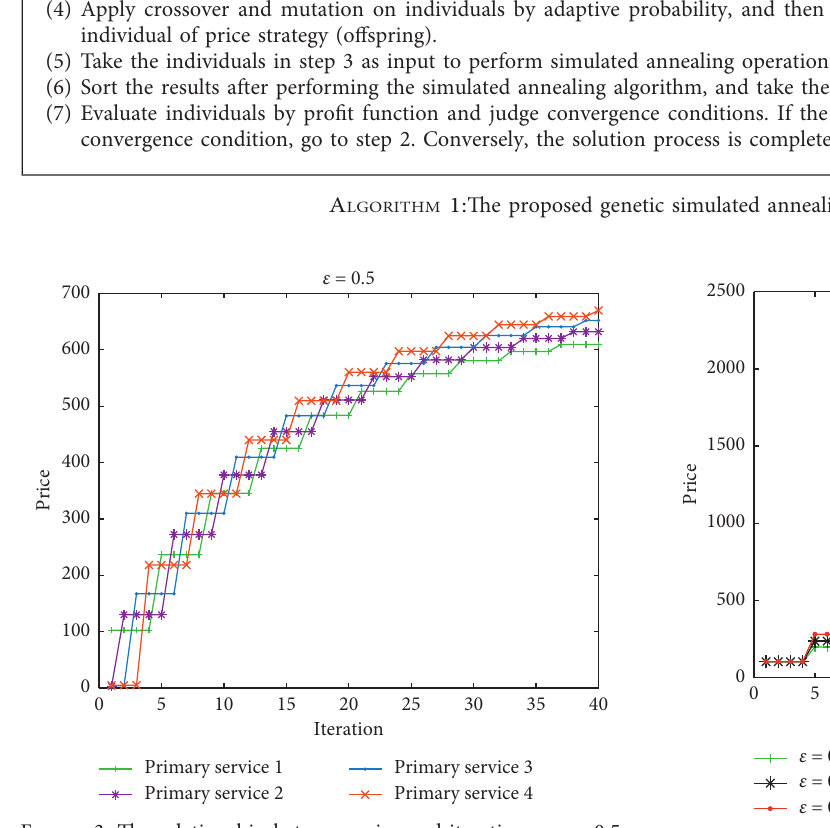
Figure 4: The relationship between price and iteration on different ε for one PSP. Table 1: The NE of price on different ε when PU �